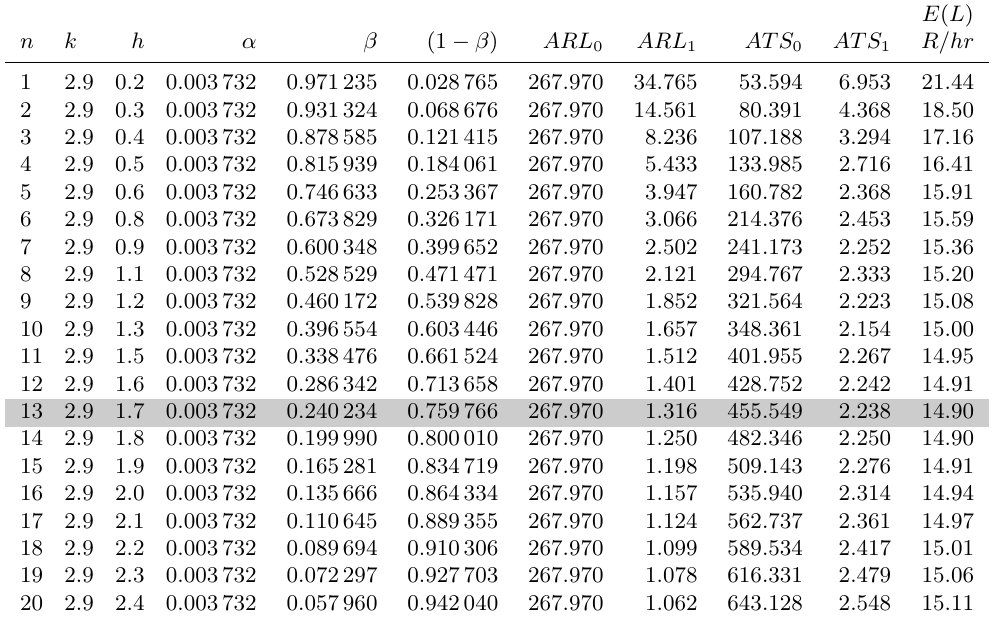
Table 2: Optimal economic statistical designs with ARL